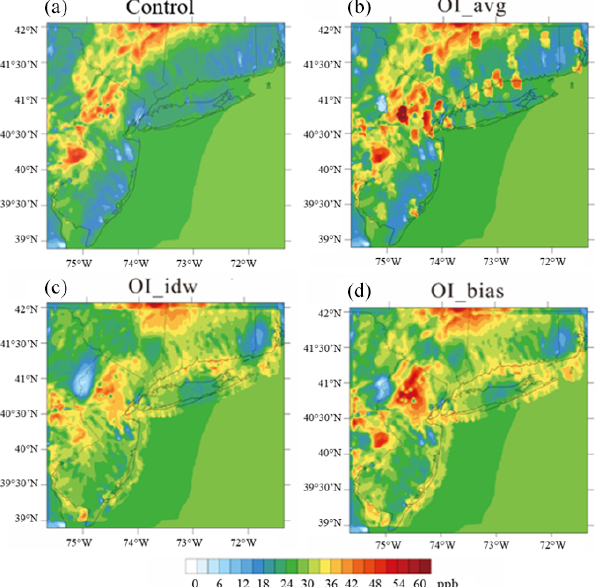
Figure 5. Spatial distributions of predicted surface O 3 concentra- tions using three optimal interpolation (OI) approaches (OI_avg, OI_idw and OI_bias) at 00:00UTC on 26 August